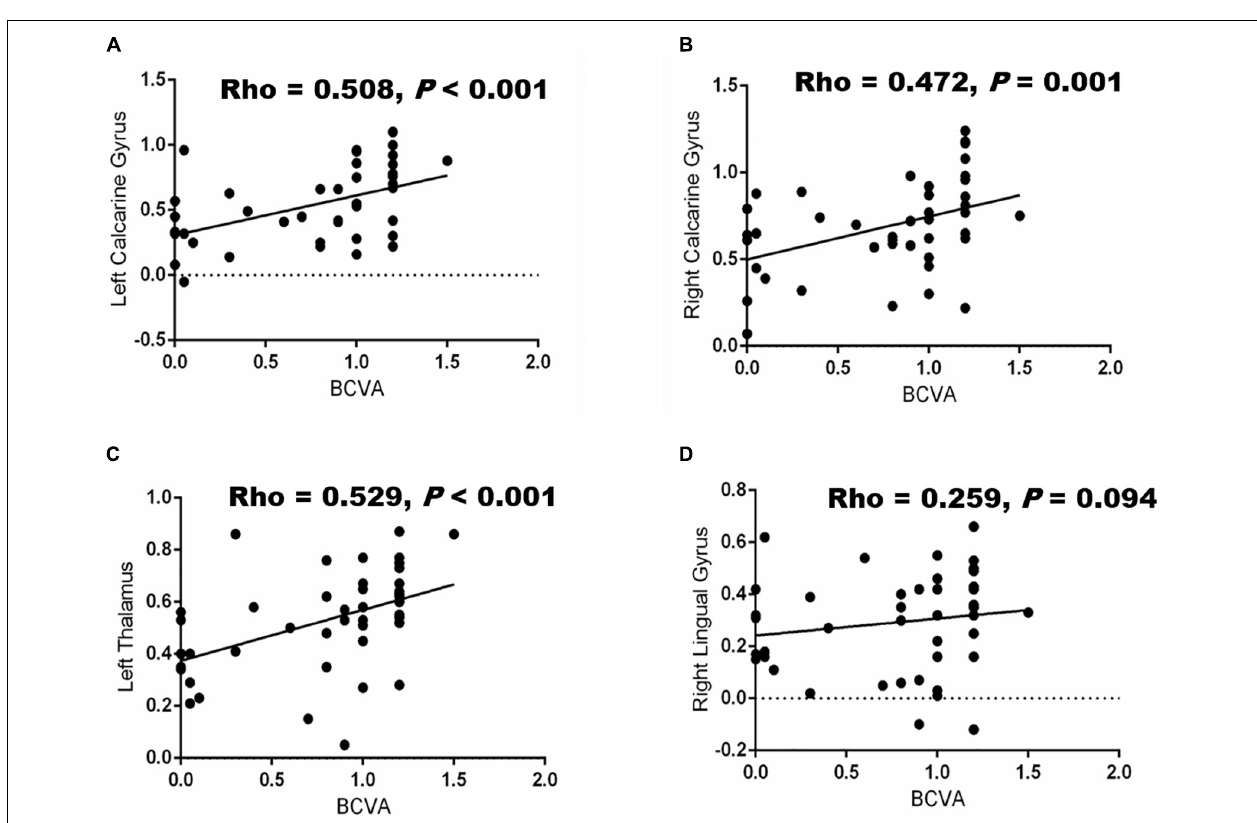
FIGURE 3 | Correlation between BCVA and functional connectivity (FC) values in different brain regions. Significant associations ( P < 0.05) were shown between BCVA and the changes in FC values of the brain in the left calcarine gyrus (A) , right calcarine gyrus (B) left thalamus (C) and right lingual gyrus (D) , respectively.